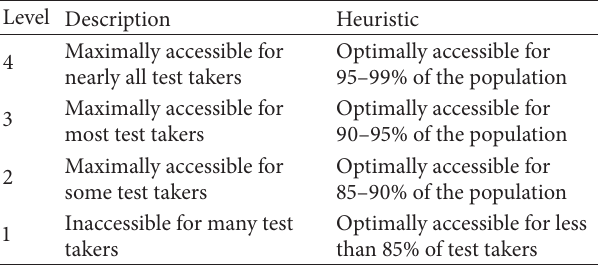
Table 1: Test item accessibility levels.